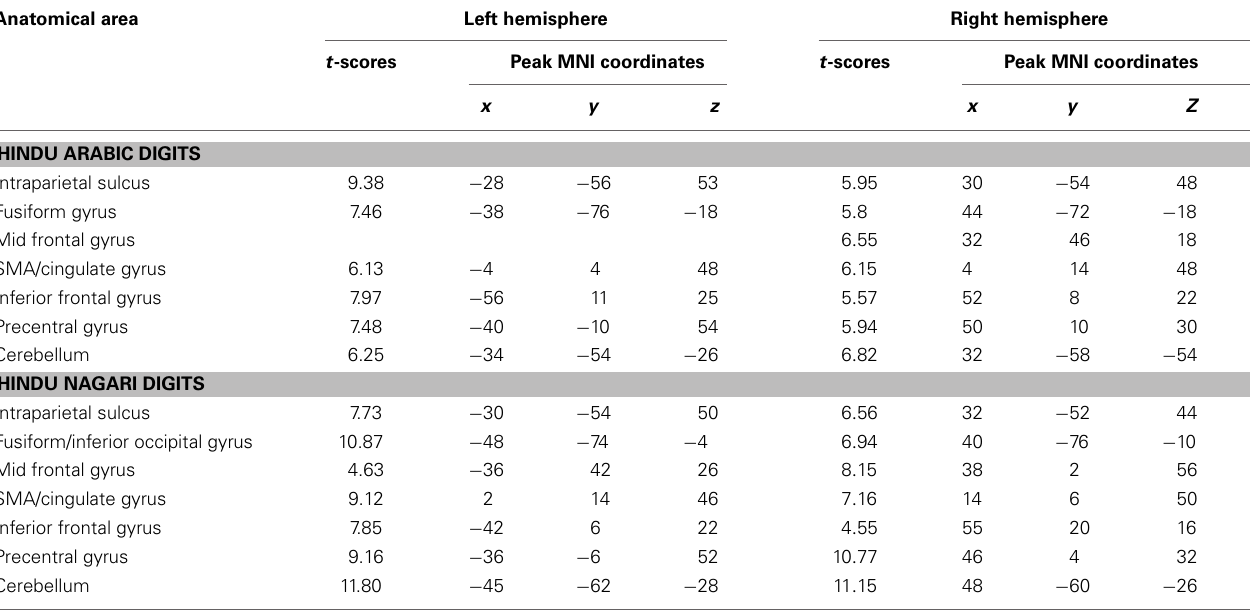
Table 3 | Peak coordinates from significant regions of activation in Ar and Ng comparison tasks. Anatomical area